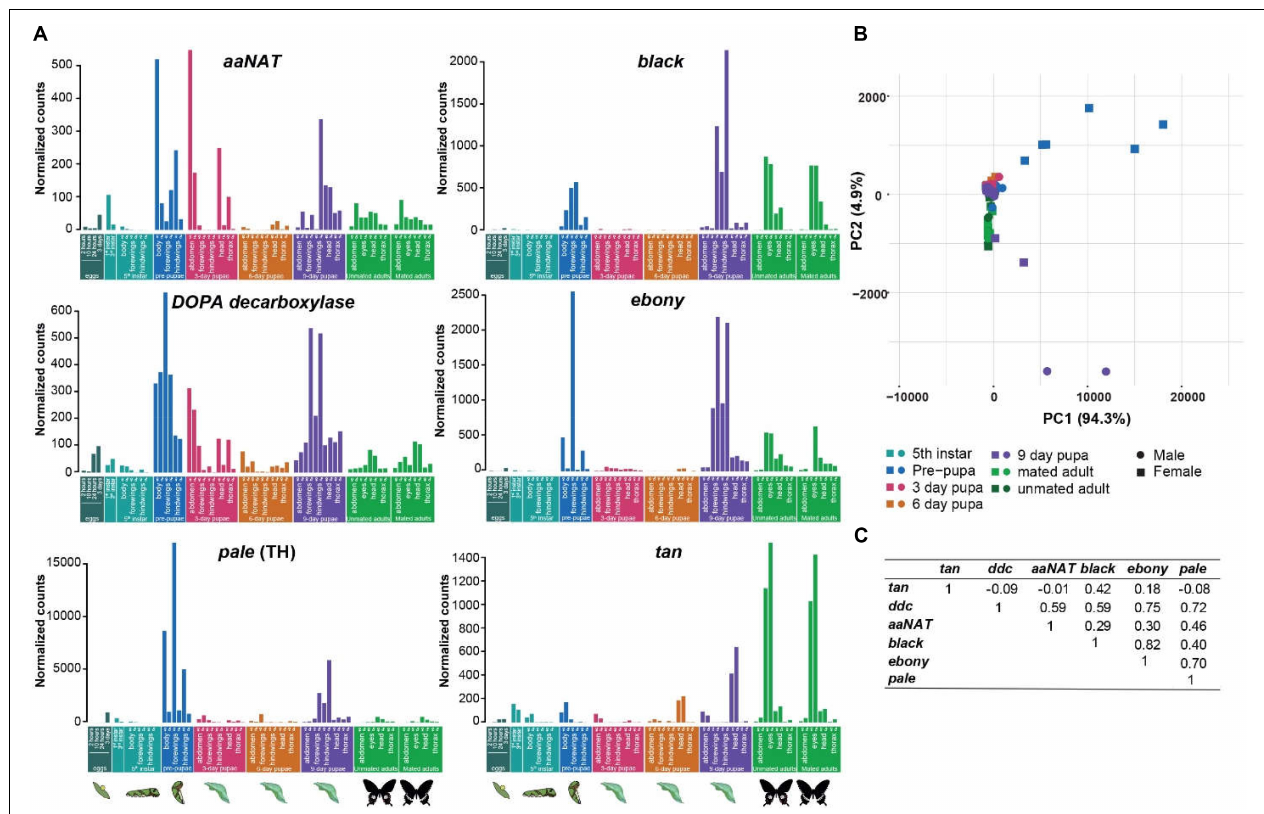
FIGURE 3 | (A) Expression of the six melanin pathway genes across developmental stages of Papilio polytes . Means of normalized counts for each stage, tissue and sex (beyond 5th instar larvae) obtained from transcriptome data are plotted. The developmental stages are color-coded and pictorially represented at the bottom (instar indicates larval instars). (B) Principal component analysis (PCA) of normalized expression data across developmental stages, tissues and sexes for five genes. (C) Pairwise Pearson correlation coefficients for co-expression profiles of the six genes.